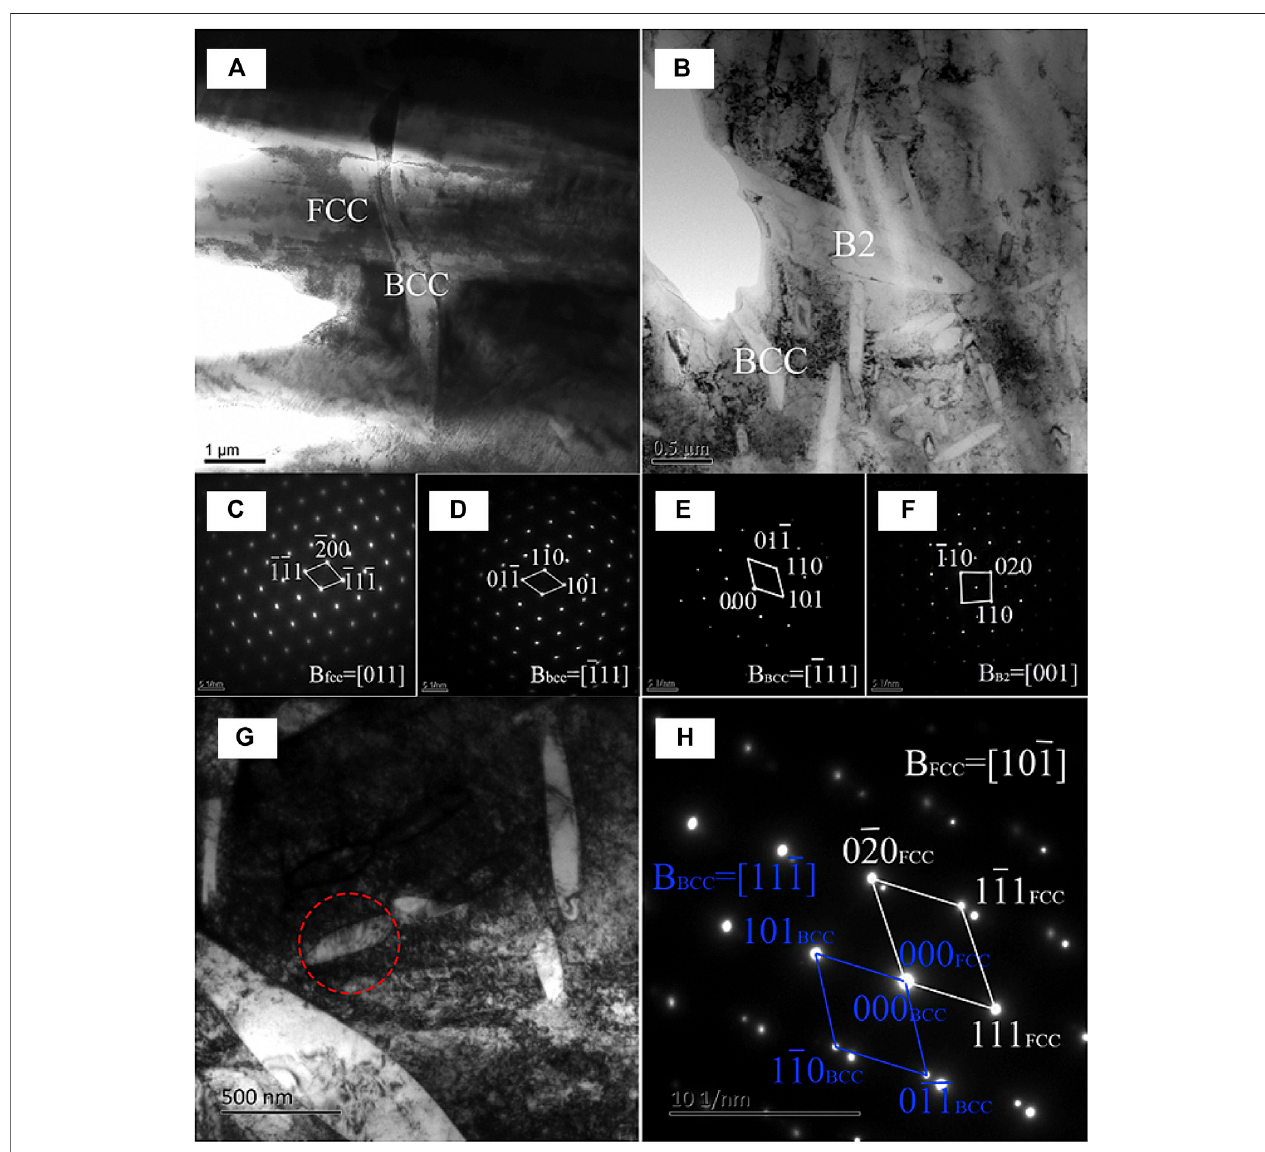
FIGURE 1 | TEM bright images (A) as-cast alloy, (B , C) corresponding selected electron diffraction imagem (D , G) heat-treated alloy at 1,123 K/8 h, and (E – H) correspondingselectedelectrondiffractionimage(Wangetal.,2017a).(ReprintedfromJournalofAlloysandCompounds, Vol710,Wang etal.,TheFCCtoBCCphase transformation kinetics in an Al0.5CoCrFeNi high entropy alloy, Pages No.148, Copyright (2017), with permission from Elsevier).